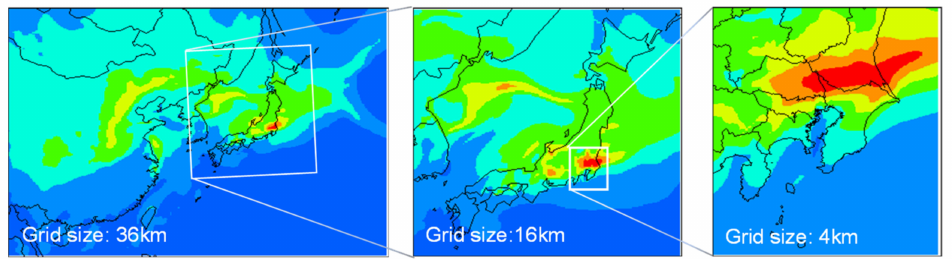
Figure 12. Configuration of JATOP Urban Air Quality